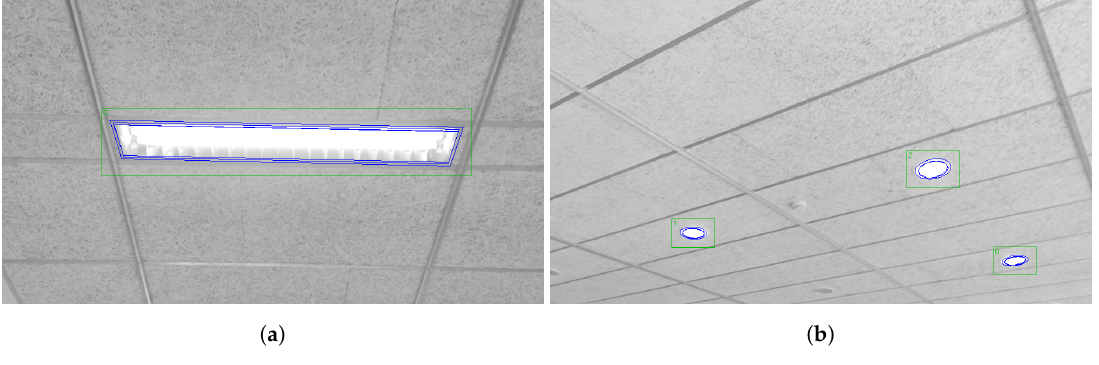
Figure 7. Examples of detections for different shapes: ( a ) rectangular; and ( b ) circular.